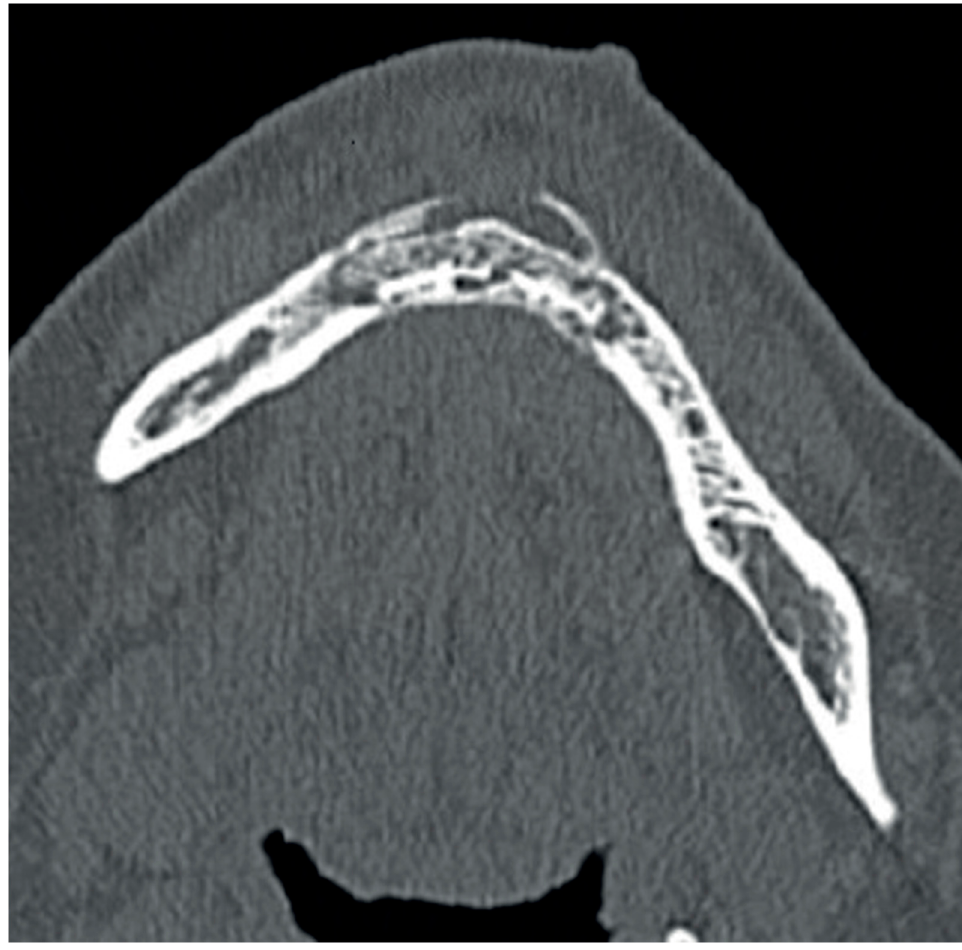
Figure 2. Computed tomography without contrast. Osteonecrosis of the mental section of the mandibular body.